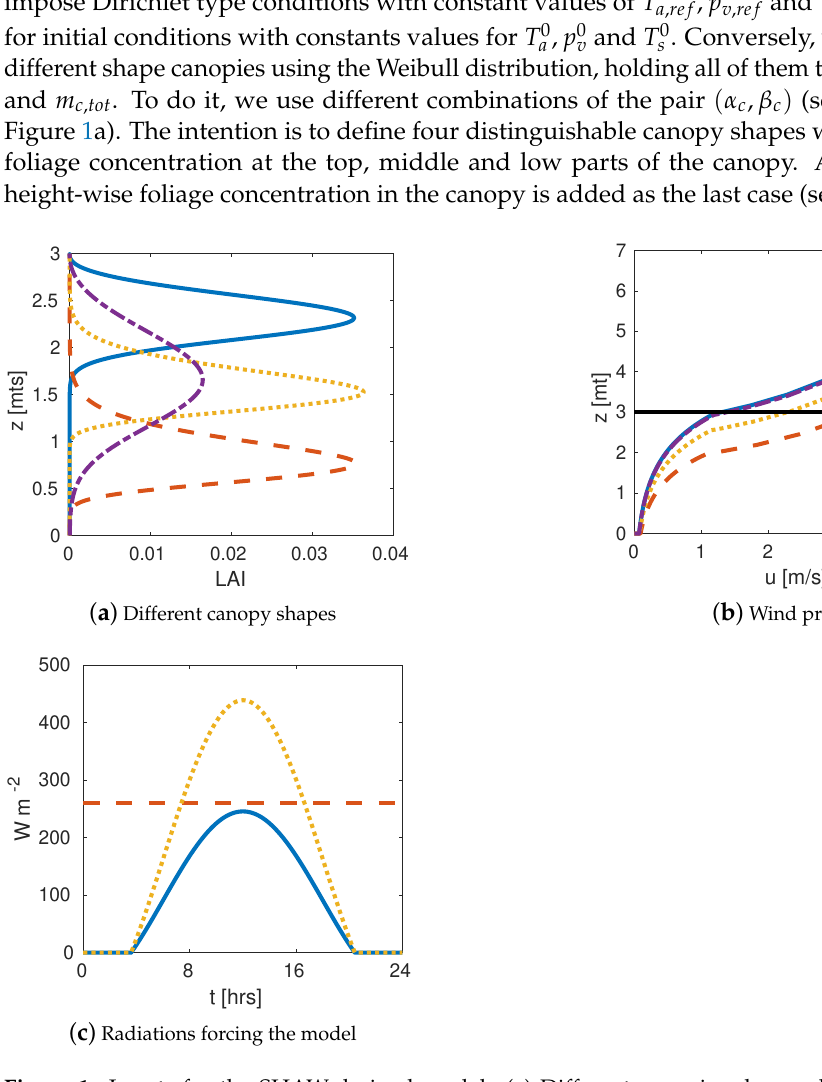
Figure 1. Inputs for the SHAW-derived model. ( a ) Different canopies shapes derived with the function LAI ( z ) given by (13) and different combinations of the parameters pair ( α c , β c ) . Cases, 1 (solid), 2 (dashed), 3 (dotted), and 4 (dash-dot). ( b ) Zoom of the Wind-profile for the four canopies shape, the black line is the canopy height. ( c ) 24 h radiation forcing from the sky at the upper layer in the canopy, Short wave-direct (solid), Short wave-diffusive (dotted), and Long wave-direct